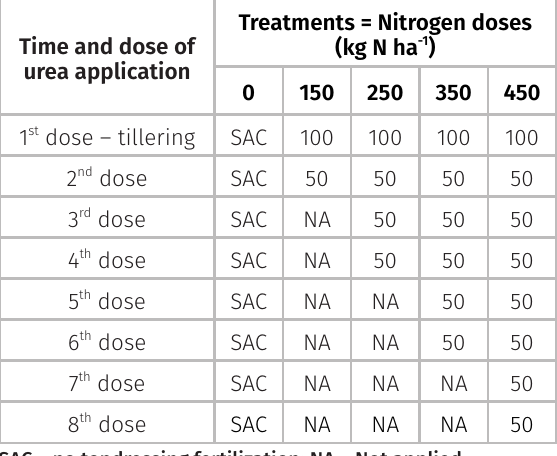
Time and dose of urea